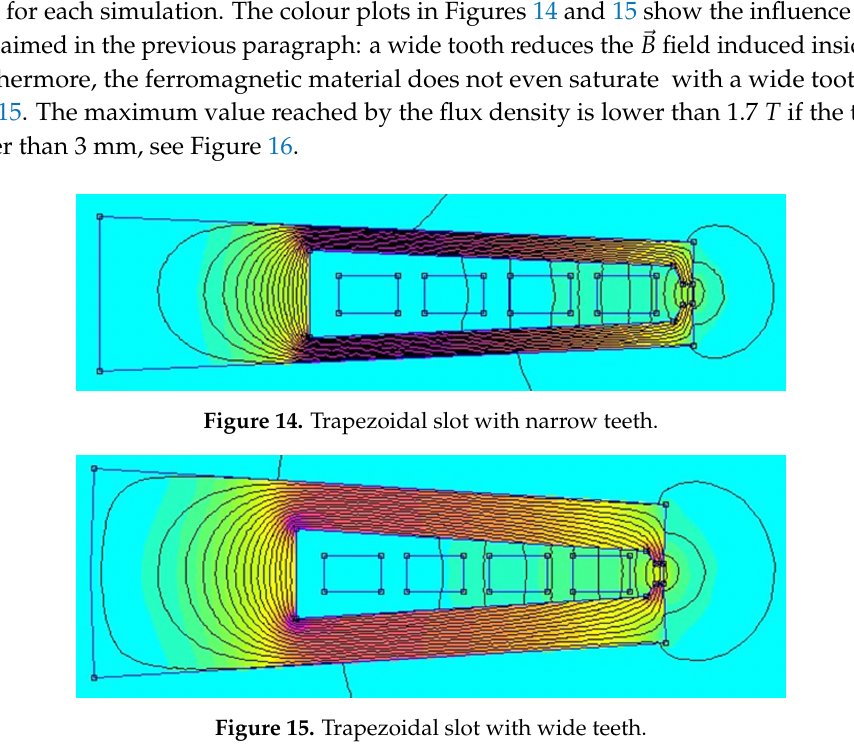
Figure 15. Trapezoidal slot with wide